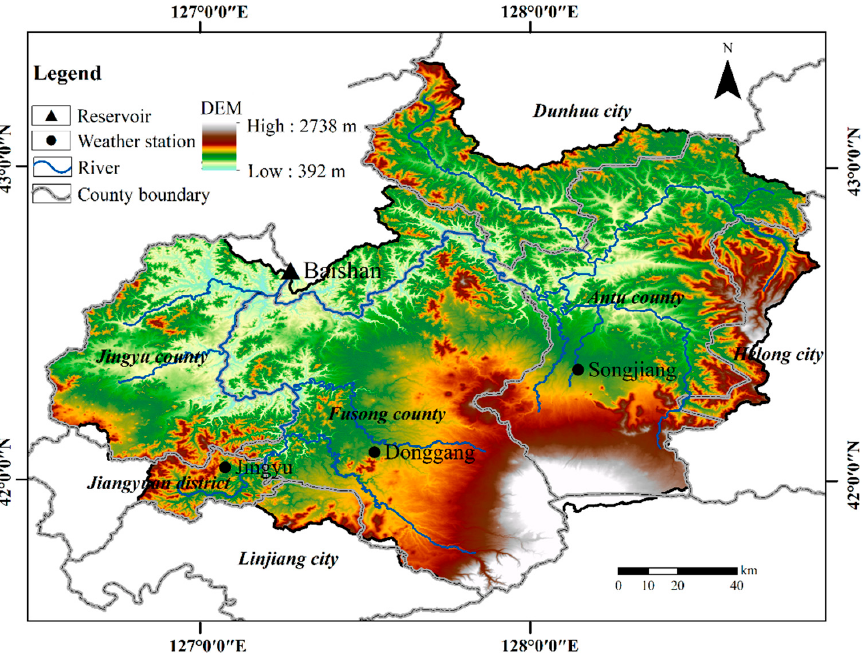
Figure 1. Map of the Baishan basin location, river networks, gauging station, and weather stations.